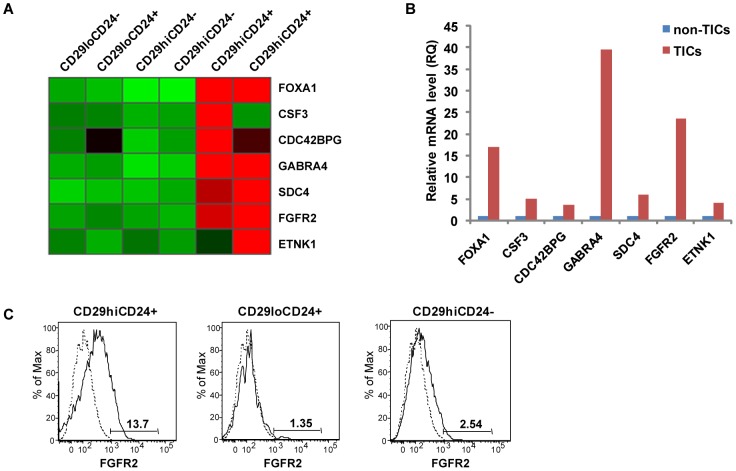
Gene Expression Profiles of Breast TICs and Non-TICs Revealed that FGFR2 Is Preferentially Expressed in Breast TICs.(A) Heat map of microarray analysis depicting the expression levels of the mRNAs of 7 genes that are significantly upregulated in the TIC population compared with the three other non-TIC populations. RNA was prepared from the four FACS-sorted populations of primary MMTV-PyMT breast tumors. Red and green indicate high and low mRNA expression levels, respectively. The expression values were normalized by Z score. (B) The expression levels of the mRNAs of 7 genes in TICs and non-TICs, as determined by quantitative real-time PCR. cDNA isolated from non-TICs was used to normalize data for each primer of gene and generate RQ (relative quantity). (C) The expression levels FGFR2 protein in the subpopulations by flow cytometry. This figure represents a typical result of three independent experiments. Dashed line shows isotype labeling.